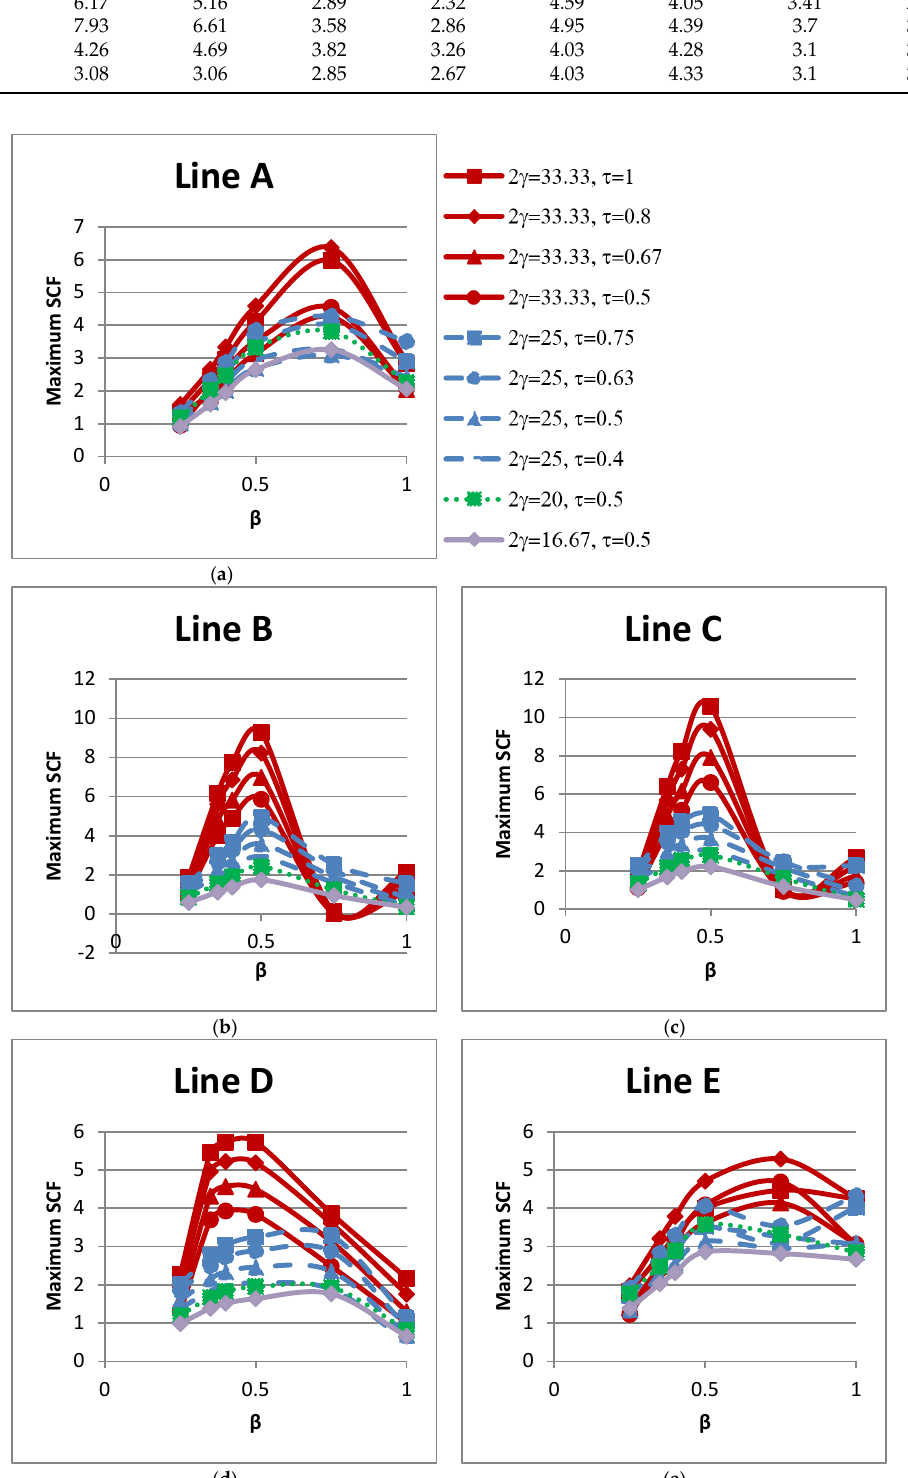
Figure 9. Influence of β on SCFs along lines: ( a ) A; ( b ) B; ( c ) C; ( d ) D; and ( e ) E.